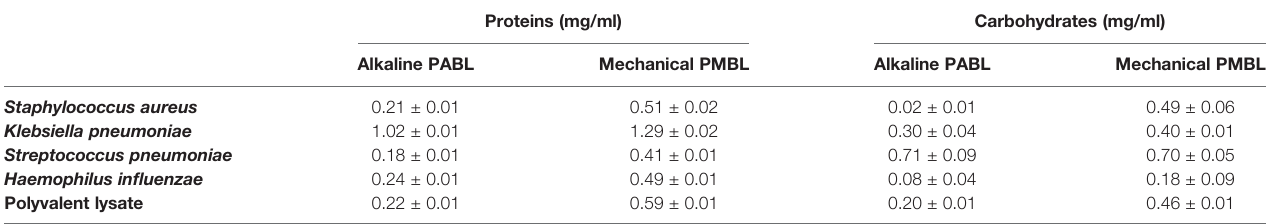
The data represent the mean of n=3 replicate ± standard deviation (S.D.) and are representative of at least 3 distinct batches of each